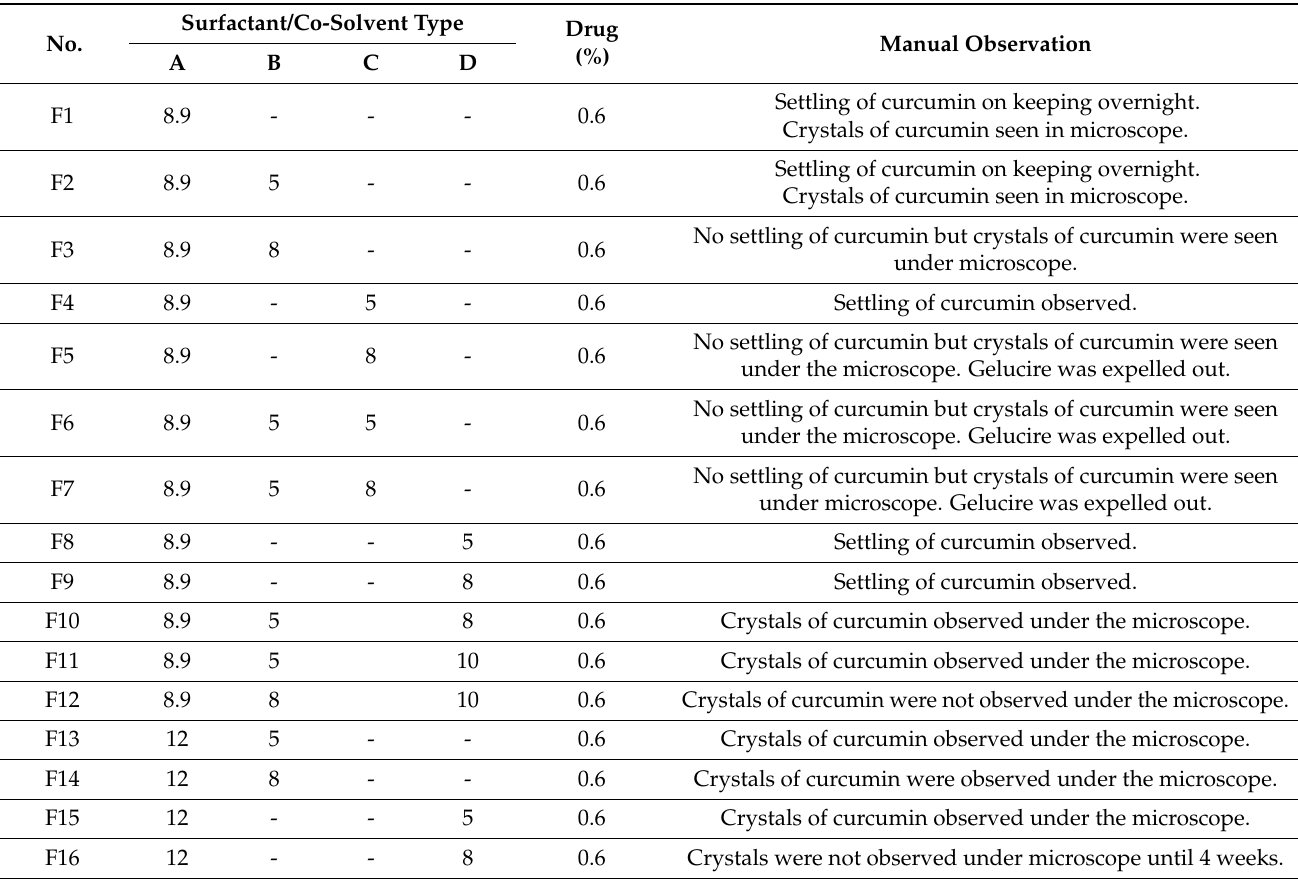
Table 3. Various formulations prepared for identifying and screening the highest and lowest concentrations of independent